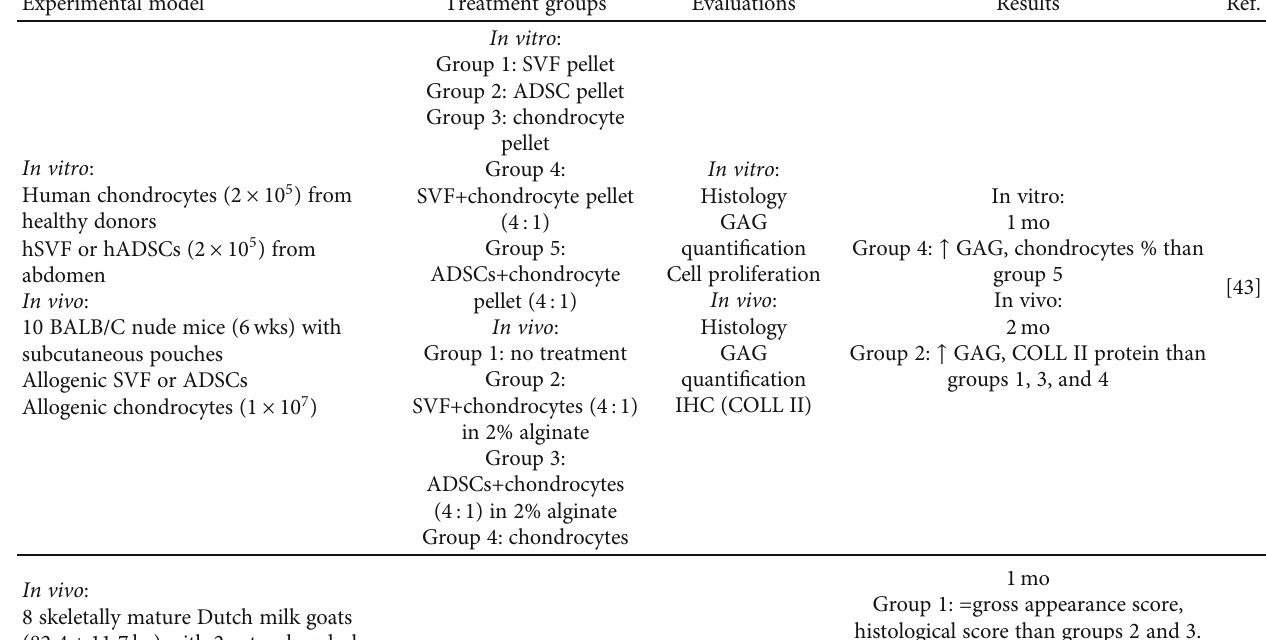
Table 2: In vitro , in vivo , and clinical studies on SVF in cartilage regeneration. Experimental model